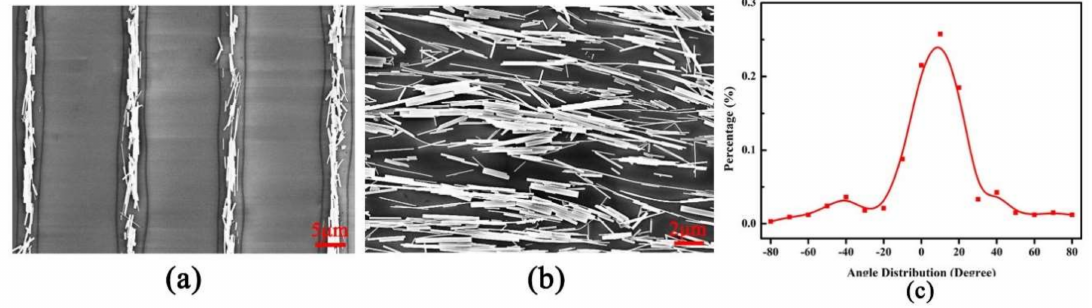
Figure 3. ( a ) FESEM image of four nanowires arrays; ( b ) the zoom-in image of the first column; and ( c ) the angle distribution of ZnO nanowire in the first